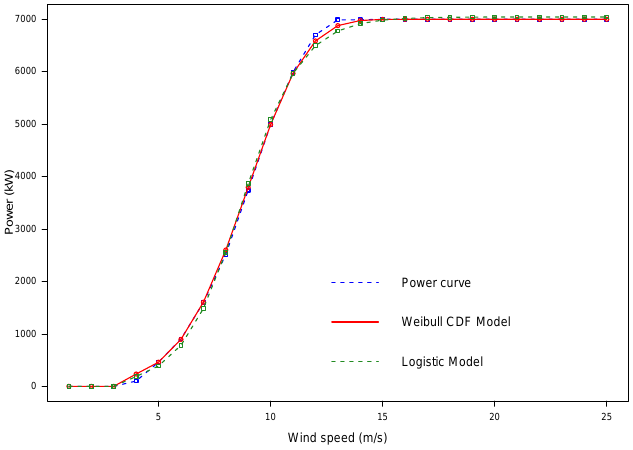
Figure 7. Weibull CDF and 4P-OP models for the Vestas V164 2-MW power